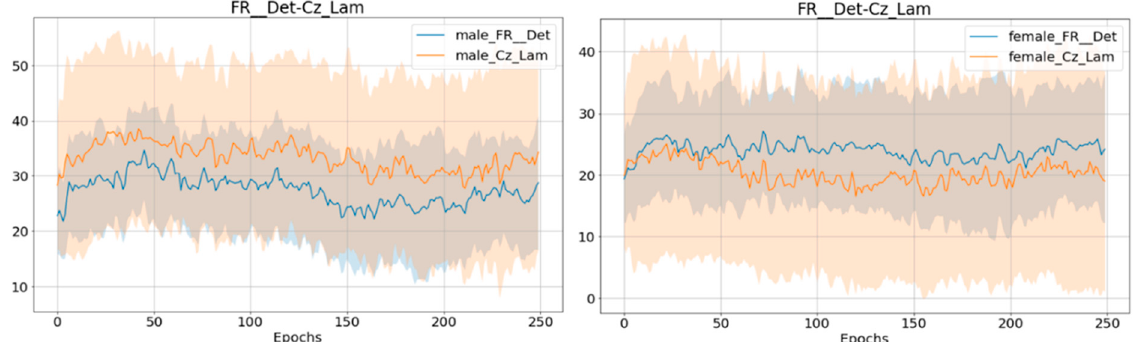
Figure 3. Left: highly correlated (0.79) determinism (Det) from the FR region and laminarity (Lam) from the Cz channel for male drivers; right: weakly correlated (0.37) determinism (Det) from the FR region and laminarity (Lam) from the Cz channel for female drivers. The Y -axis shows the values of the observed features. The bold line is the mean of the feature, and the filled area represents the standard deviation.